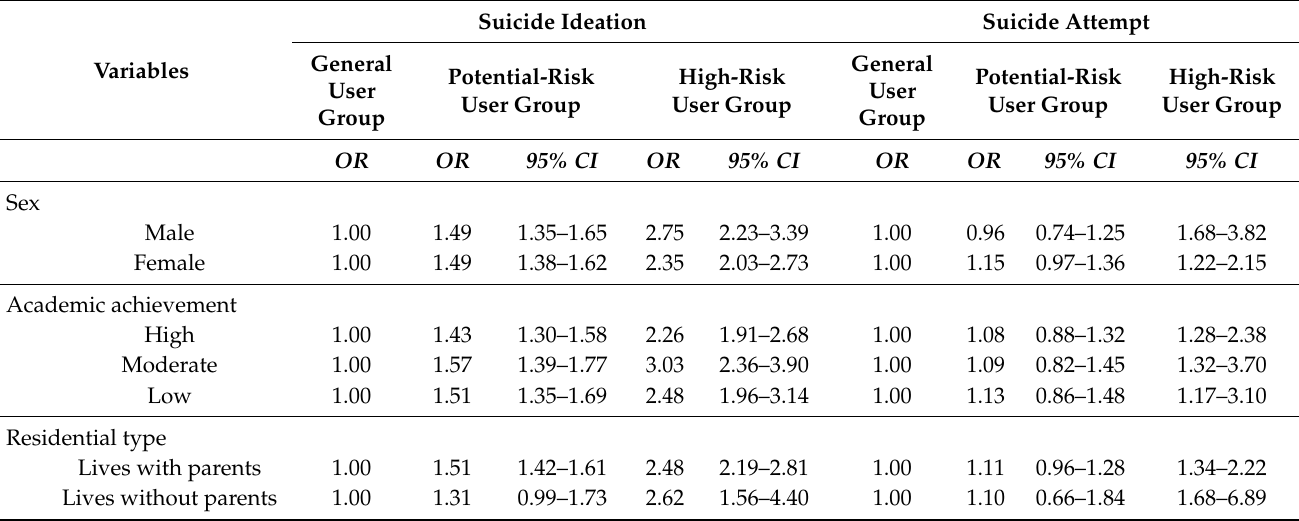
Table 4. The results of subgroup analysis stratified by are independent variables.